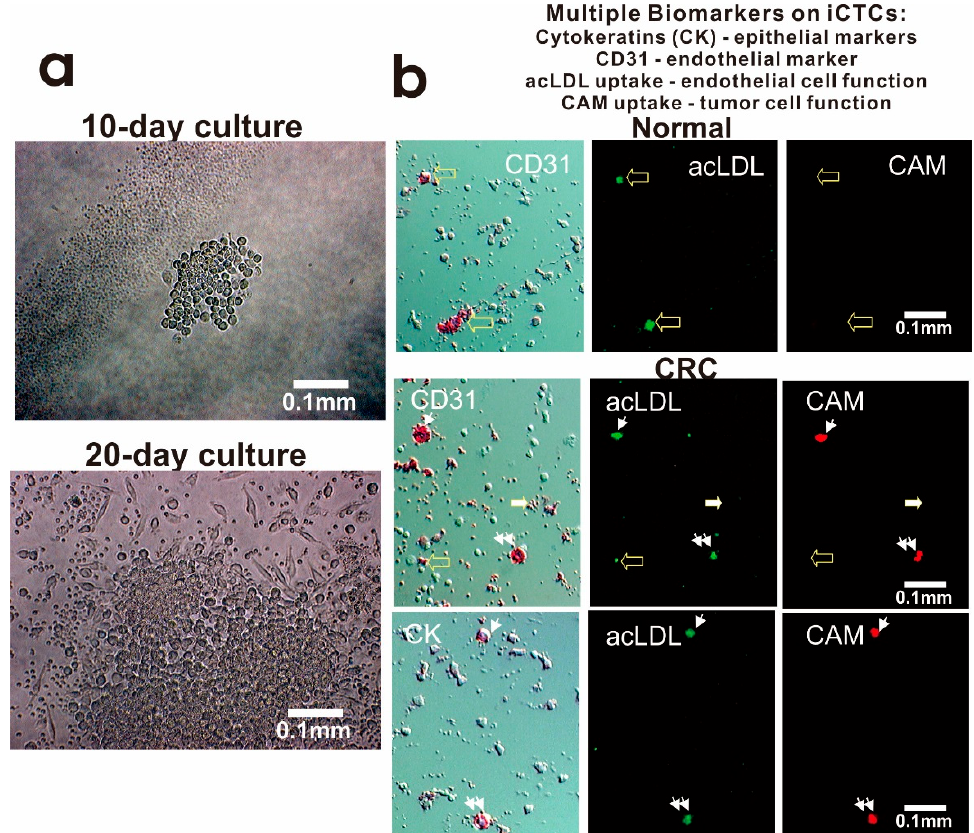
Figure 5 . Proliferative and invasive activities and expression of multiple cell lineage markers of iCTCs in blood of CRC patients. ( a ) Proliferation and differentiation of iCTCs into epithelial colonies ex vivo. CAM-enriched cells were cultured on the CAM scaffold for ten days and twenty days. Live cells were photographed under phase contrast microscopy. Tumor cells grew in clusters with large epithelioid cells but hematologic cells (solitary small cells and platelet-like cell fragments seen in the lower image) decreased in number and became not evident; ( b ) iCTCs express epithelial and endothelial biomarkers as well as display epithelial and endothelial functions. Cell multipotency of iCTCs was verified in single cells using expression of epithelial cytokeratins (CK) and endothelial CD31, acLDL uptake of endothelial function, and CAM uptake of tumor progenitor cell function. Background cells that were not labeled with antibody staining were leukocytes and platelets co-isolated with iCTCs. ( Upper ) panel: circulating endothelial cells in normal blood were seen to be CD31+ acLDL uptake+ but CAM uptake − . ( Middle ) panel: iCTCs in blood of a Stage IV CRC patient were seen to show CD31+ acLDL uptake+ CAM uptake+ (indicated by small arrows and double small arrows). However, circulating endothelial cells and platelets were seen to be CD31+ acLDL uptake± CAM uptake − (indicated by large solid and open arrows). ( Lower ) panel: iCTCs in blood of a Stage IV CRC patient were seen to show CK+ acLDL uptake+ CAM uptake+ (indicated by small arrows and double small arrows).